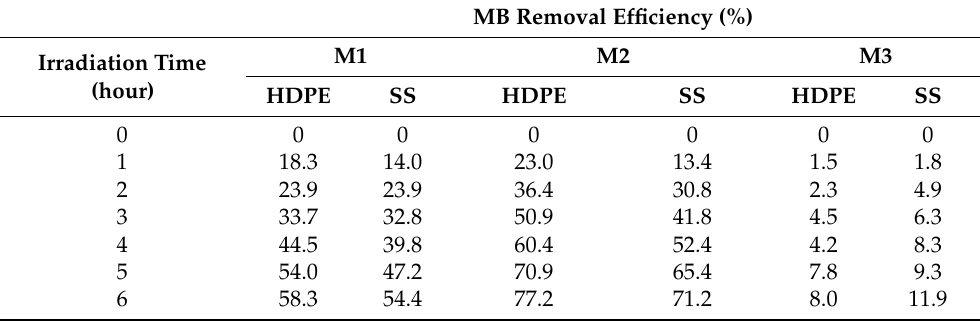
Table 2. MB removal efficiencies (%) by P25 TiO 2 immobilized by three methods (M1, M2, M3) on two study materials (HDPE,